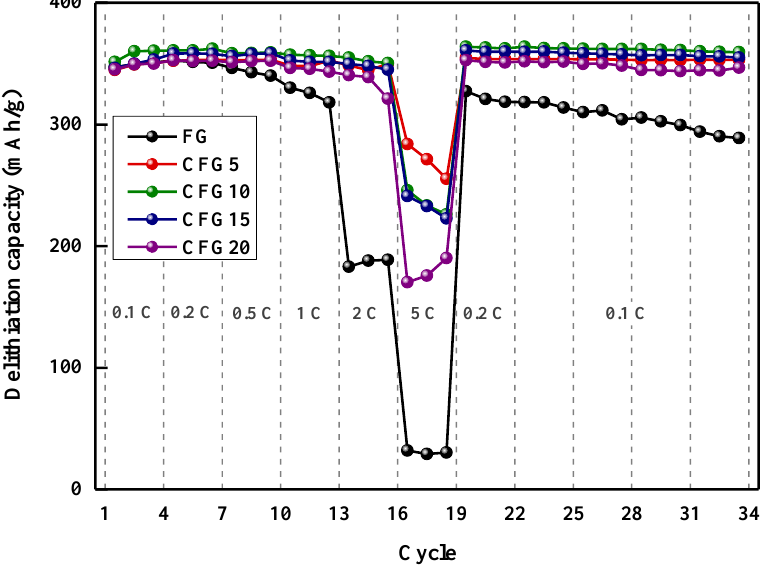
Figure 4. Rate performance at various delithiation rate (1 C rate = 372 mAh/g) and cycling performance at 0.1 C.